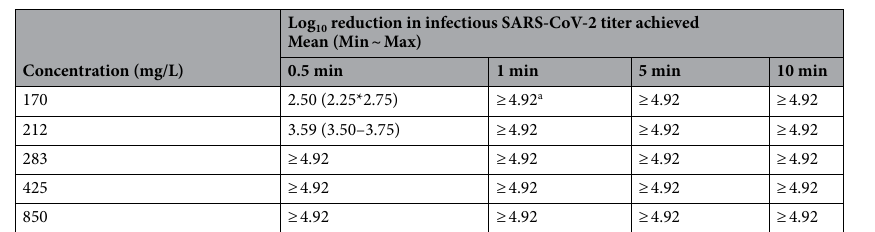
Table 5. Effect of Di-N-decyl dimethyl ammonium chloride (DNC) on SARS-CoV-2 inactivation. a The value of ≥ 4.92 means that no live virus is observed after the treatment, while the smaller values indicate that a different amount of virus survives after the treatment.